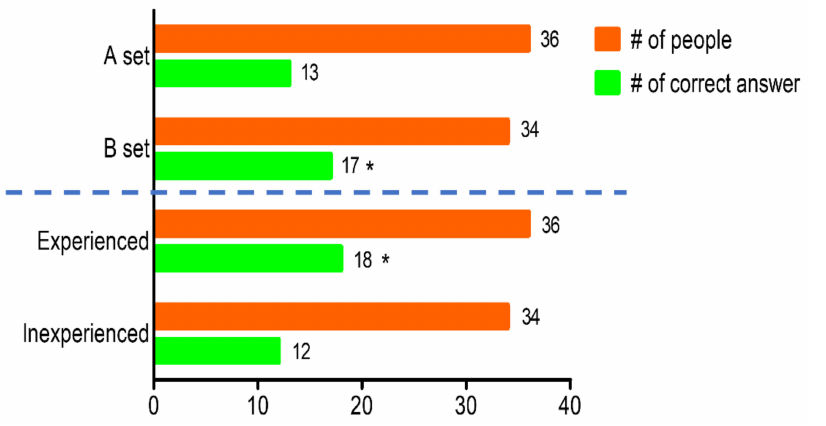
Figure 4. The number (#) of people who chose one sample as different from the other samples, and total number in each group. The data was collected by triangle test of cabbage juice made of cabbage grown under OF and APV ( n = 70). Set A contained 2 OF samples and 1 APV sample, while set B had 2 APV samples and 1 OF sample. Asterisk (*) indicates significant differences by chi-square test ( p < 0.05) between the total and the number of correct respondents.